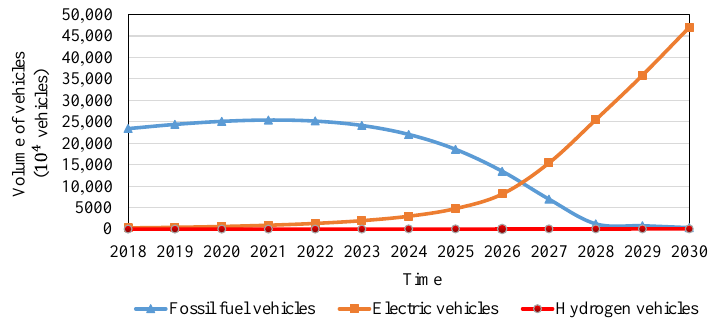
Figure 10. Number of vehicles under the fossil fuel vehicles exit